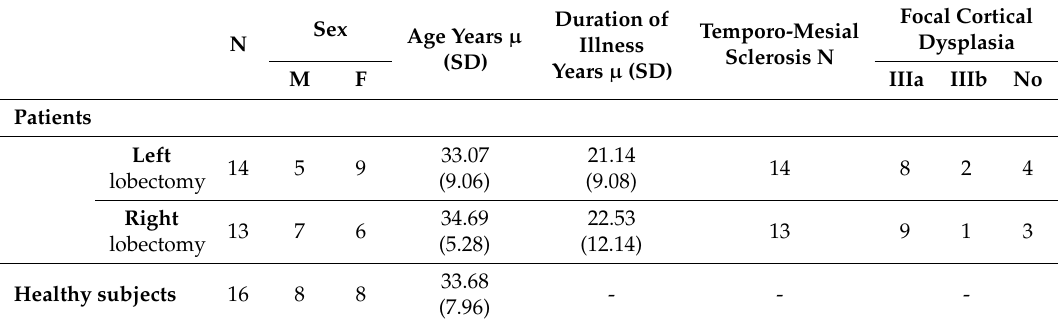
Table 1. Clinical and demographical characteristics of the sample.